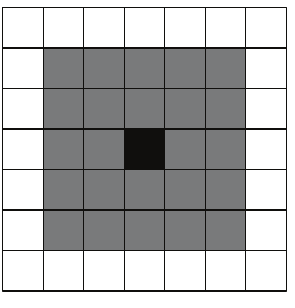
Figure 2: Moore neighborhood ( 𝑟 = 2 ).